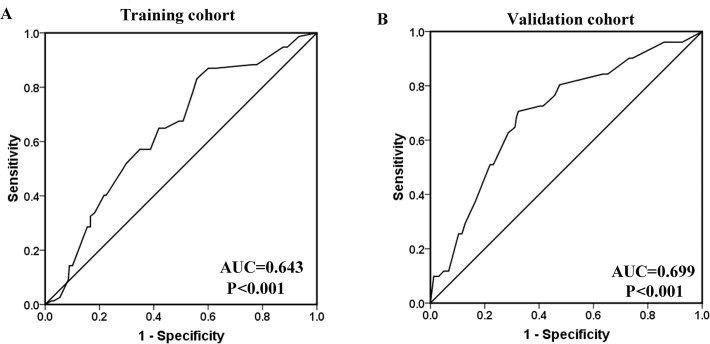
The predictive value of ULK1 expression regarding NPC patients’ treatment response.Receiver operating characteristic curve analysis for ULK1 expression was performed to assess NPC treatment response in the training cohort (AUC = 0.643, P<0.001) (A) and in the validation cohort (AUC = 0.699, P<0.001) (B).